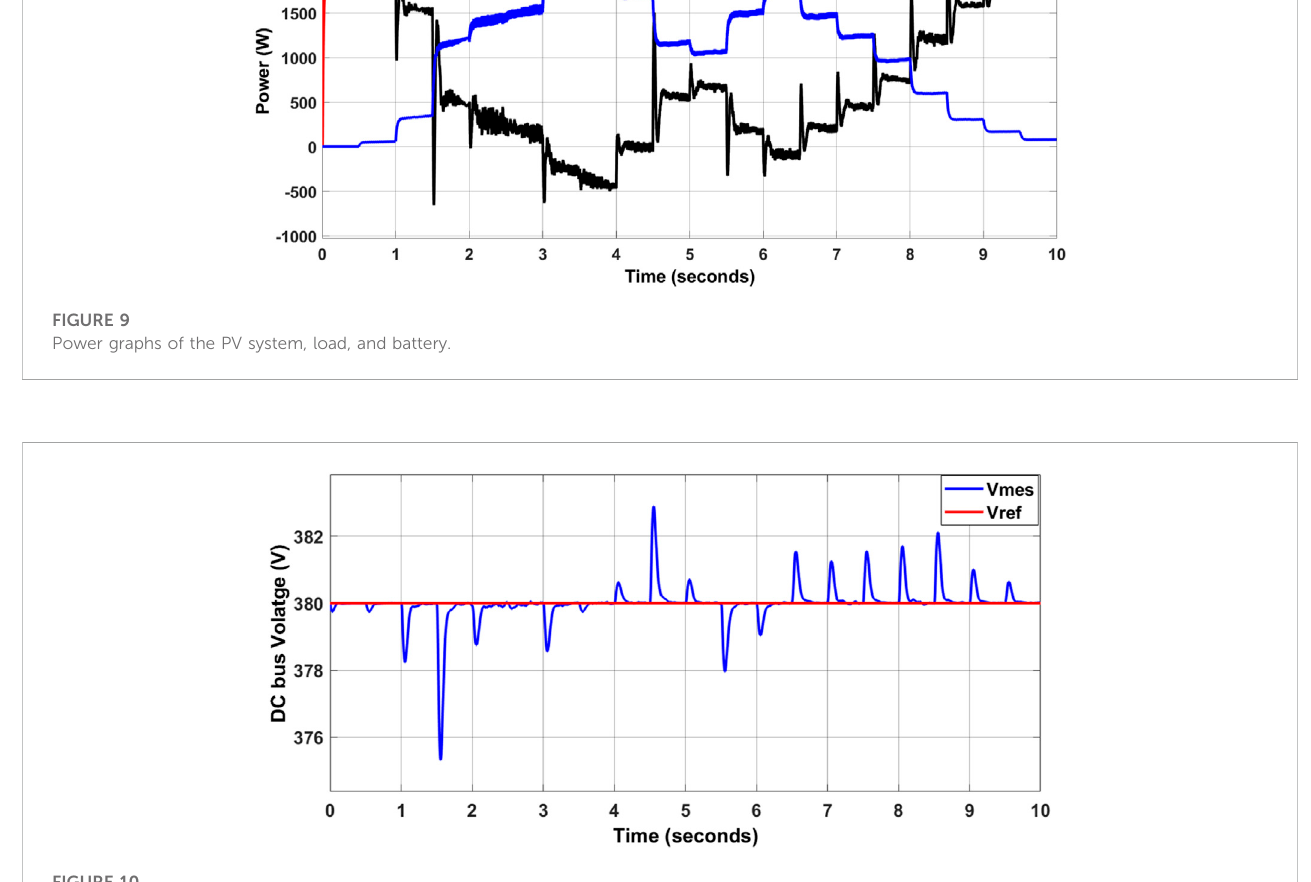
FIGURE 10 Simulation result of DC bus